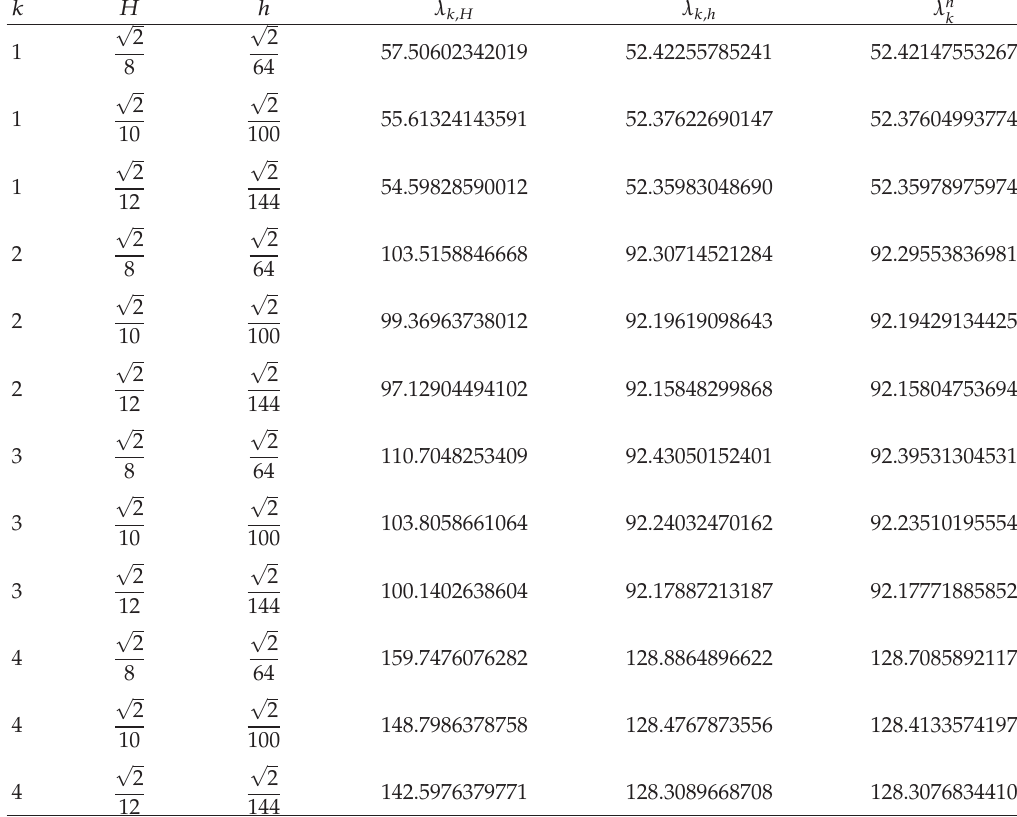
Table 1: The results on the square by Scheme 1 (cid:4) Mini element (cid:5) for Stokes eigenvalue